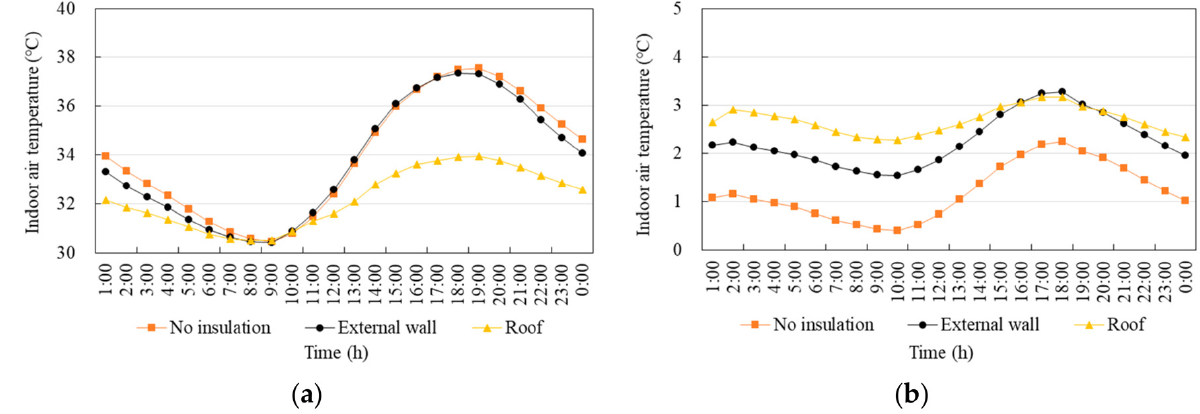
Figure 10. Air temperature variation of second floor under different insulation parts: ( a ) 31 July; ( b ) 1 January.